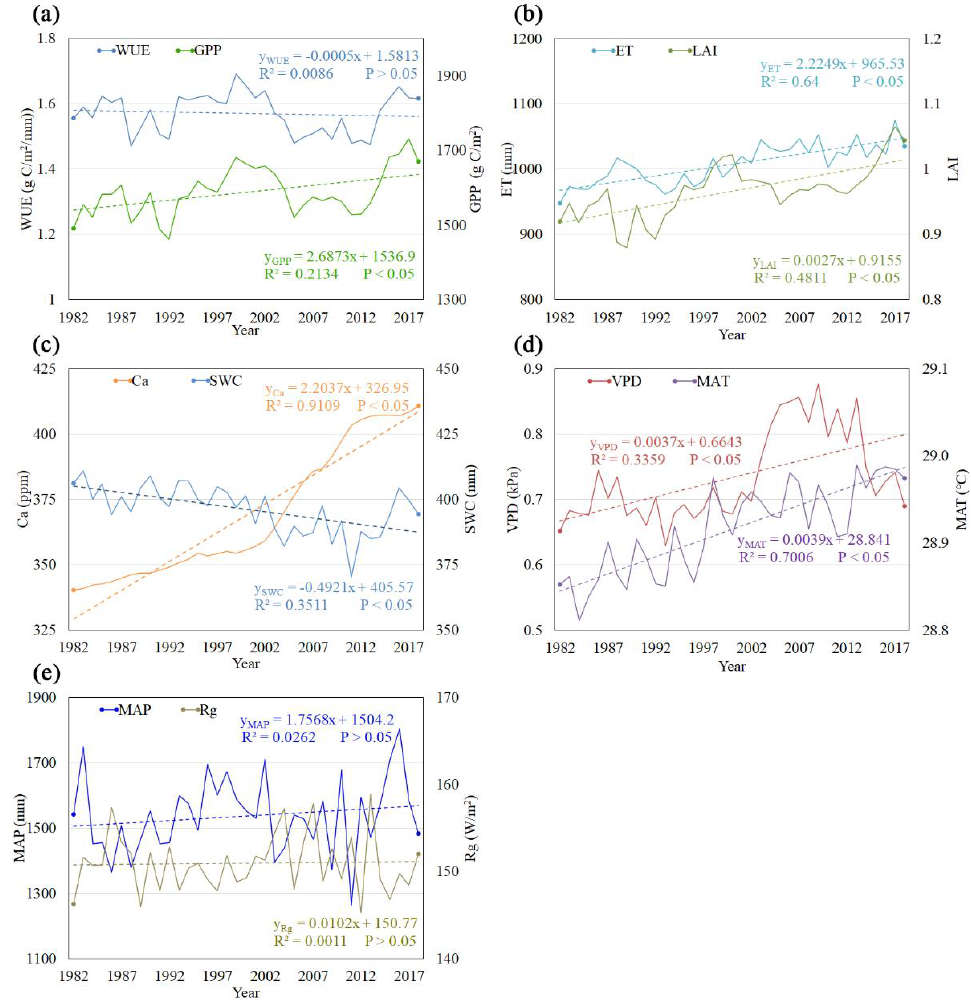
Figure 6. Time series of annual ( a ) WUE and GPP, ( b ) ET and LAI, ( c ) Ca and SWC, ( d ) VPD and MAT, and ( e ) MAP and Rg in the STC.